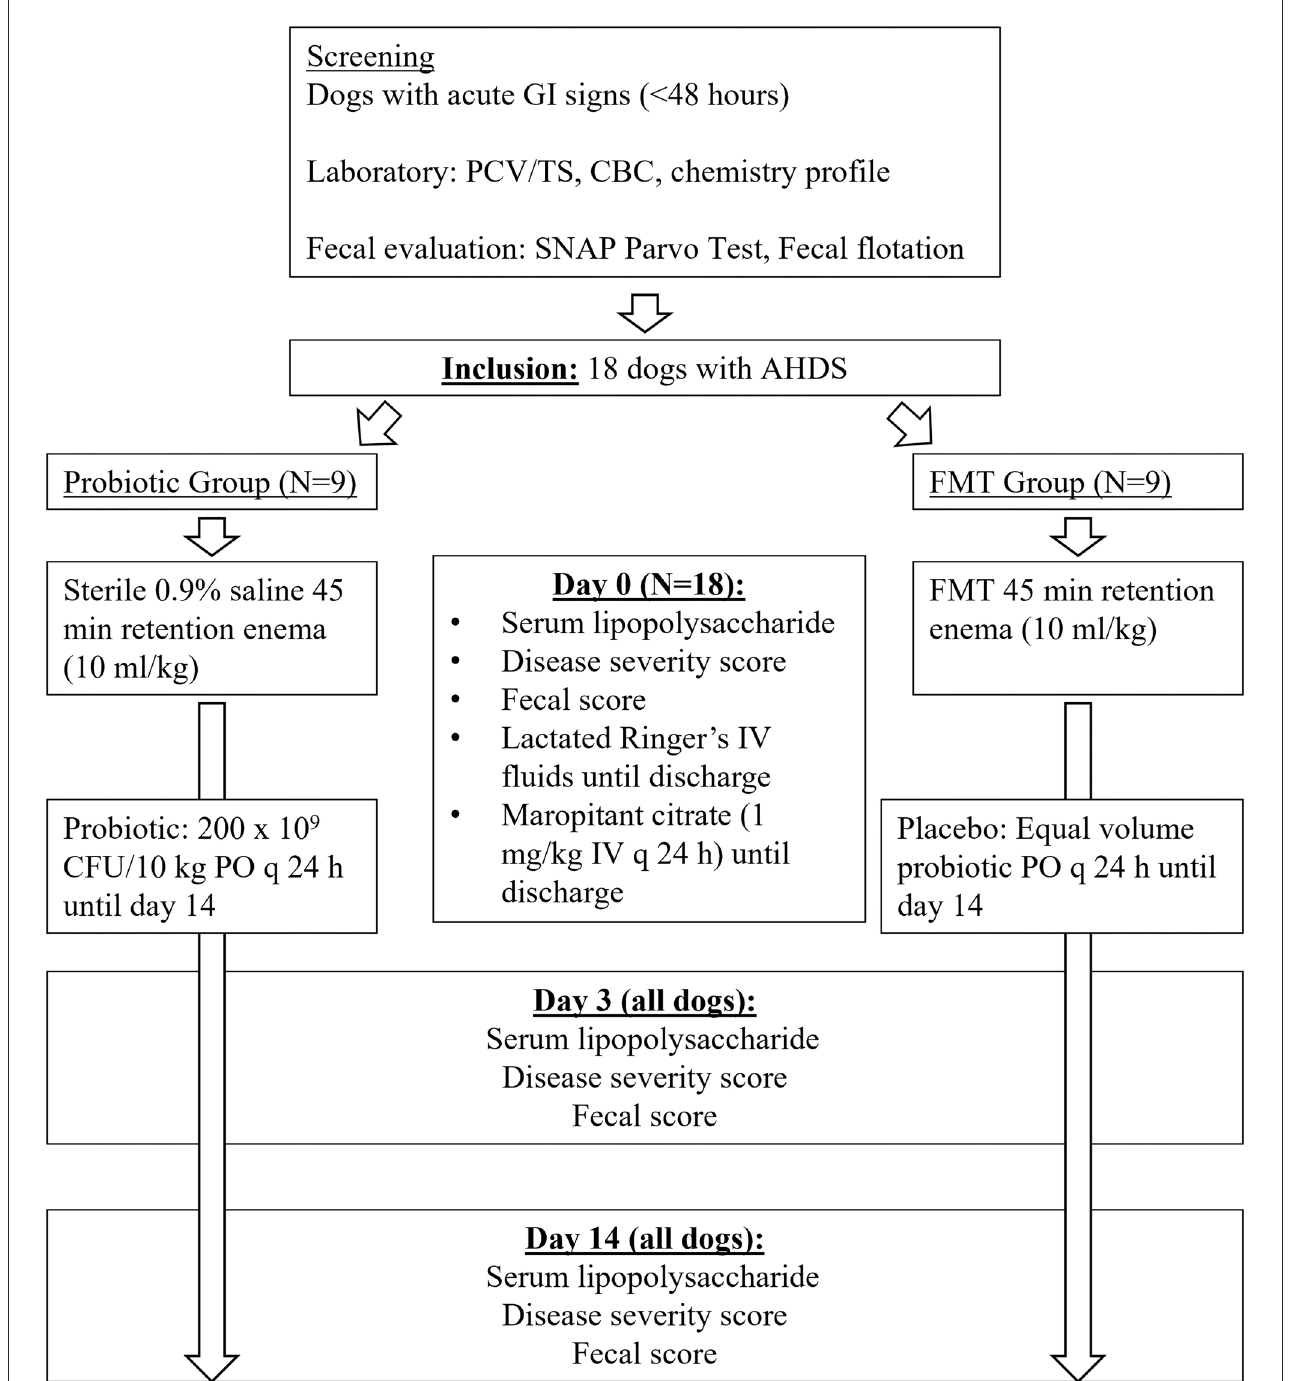
FIGURE1 Study timeline for 18 dogs with acute hemorrhagic diarrhea syndrome receiving either fecal microbiota transplant (FMT) or